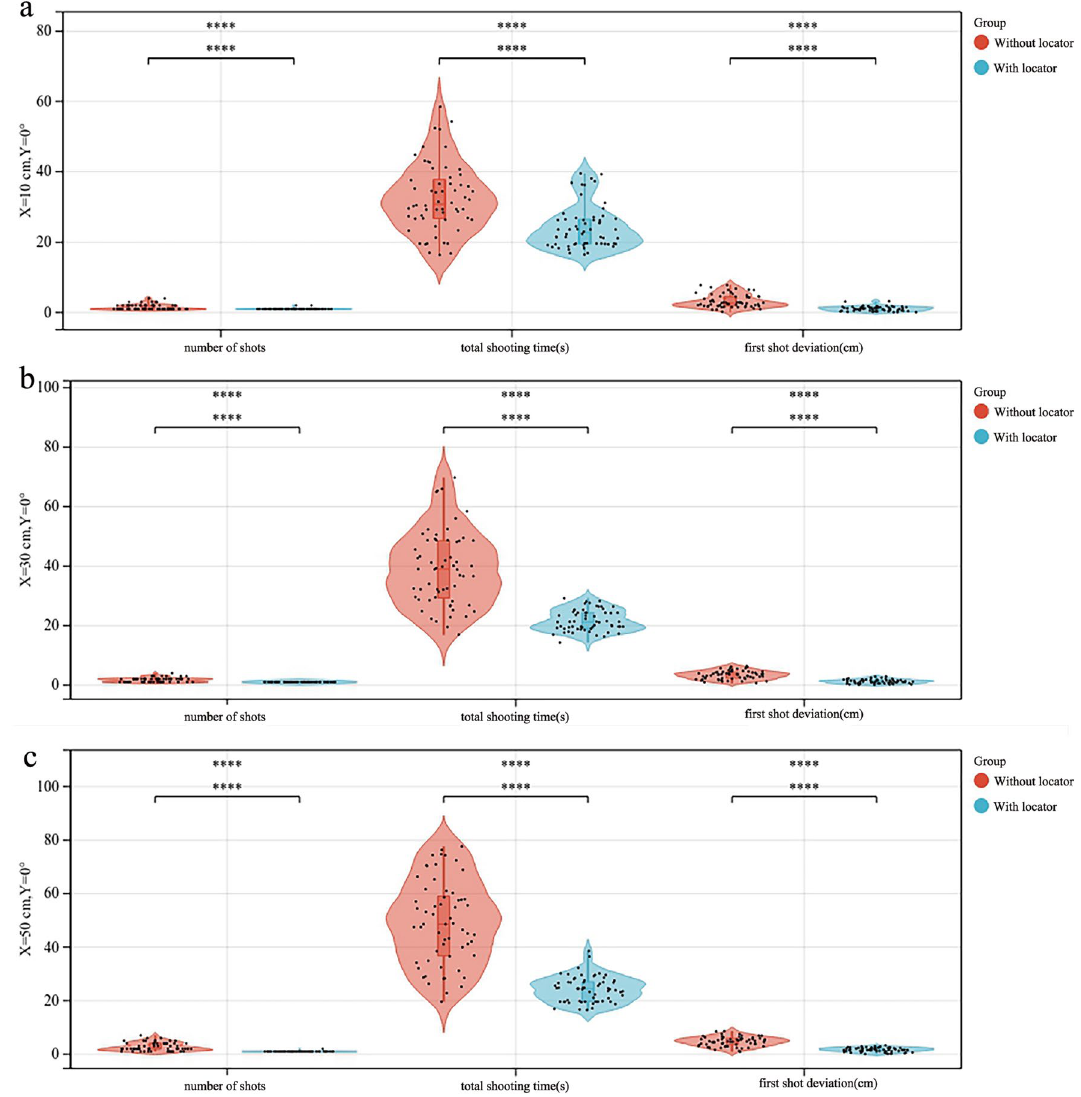
Figure 2. Comparison of the number of shots, total shooting time, and first-shot deviation between the control and experimental groups. ( a ) when X = 10 cm and Y = 0°, ( b ) when X = 30 cm and Y = 0°, ( c ) when X = 50 cm and Y =